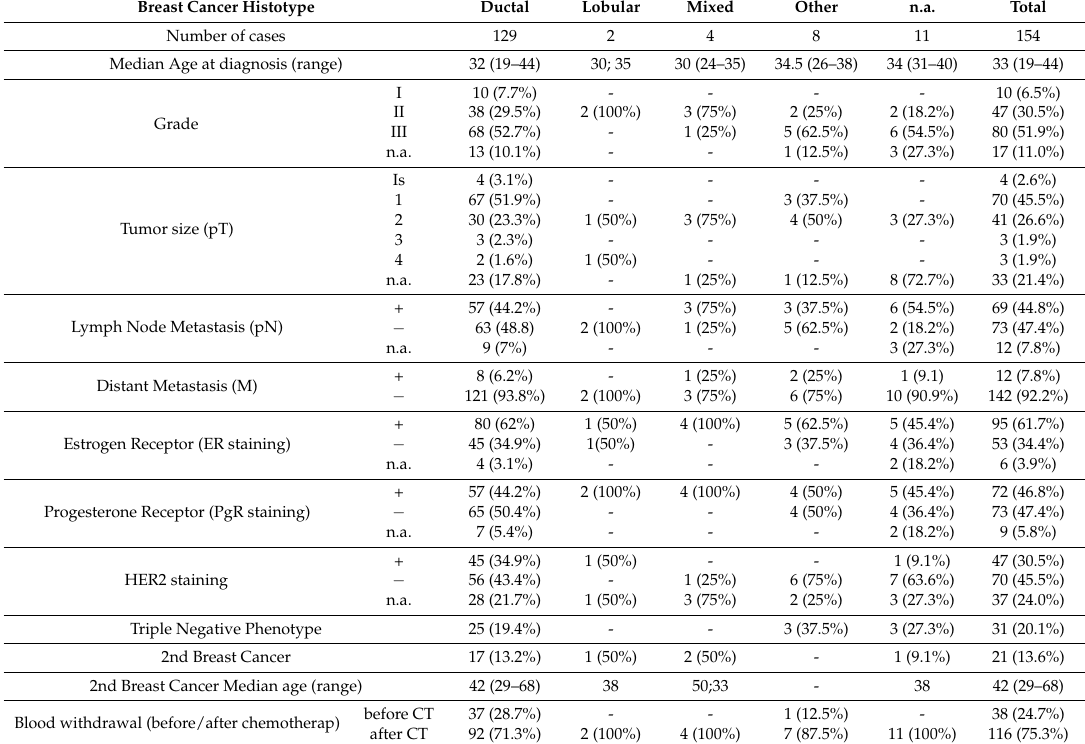
Table 1. Breast cancer (BC) features of the 154 selected patients; presence of distant metastasis, occurrence of second breast cancers and timing of blood withdrawal with respect to systemic chemotherapy are also reported; n.a., information not available.